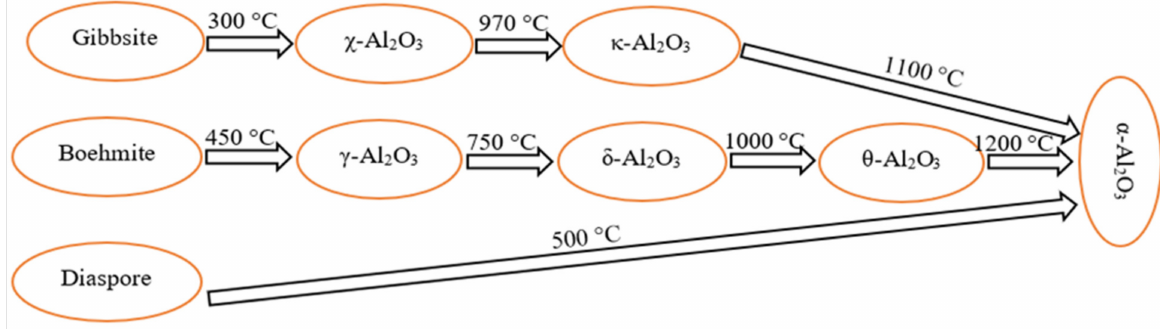
Figure 2. Phase changes of aluminum oxides/hydroxides in bauxite on